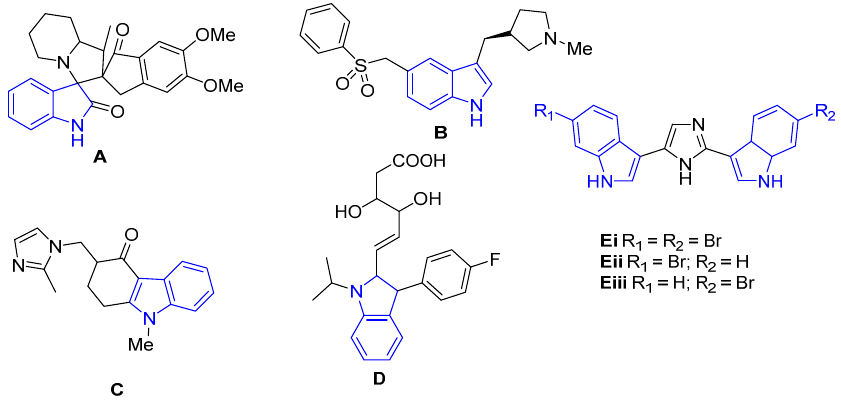
Figure 1. Biologically active compounds incorporating an indole scaffold.